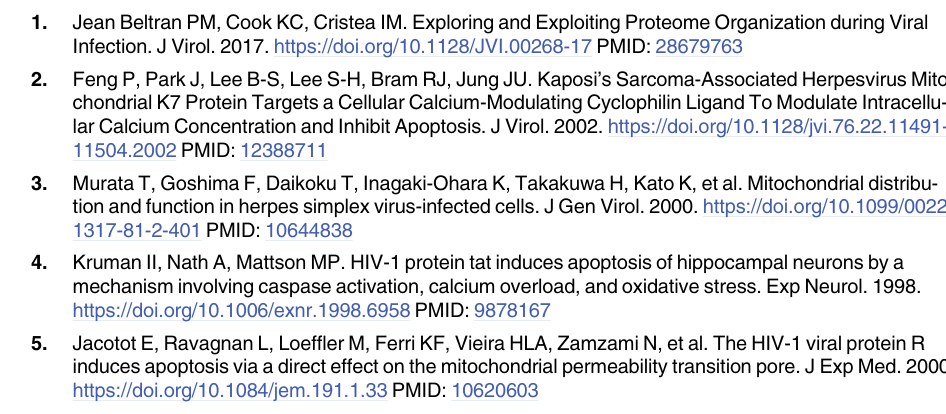
S1 Table. Mitochondrial proteome during the course of HCMV infection. S2 Table. Mitochondrial acetylome grouped by mitochondrial compartments. S3 Table. Acetylation abundances of characterized and putative SIRT3 substrates. S4 Table. Specific SIRT3 interactions at 72 hpi. S5 Table. Measurements of mitochondrial morphology. S6 Table. Temporal SIRT3 interactions overlaid with mitochondrial acetylome and prote-